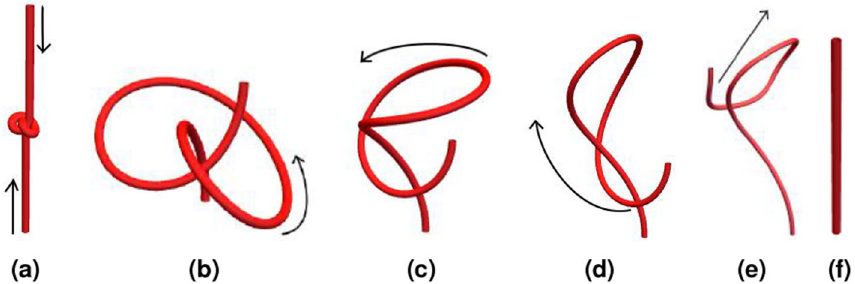
Figure 10. An “over-the-top” unknotting deformation. An initially tight knot shown in ( a ) is relaxed ( a , b ). A section of this knot is then allowed to loop over the top of one end of the curve ( b – d ). The curve is then pulled straight to an unknotted straight line ( d – f